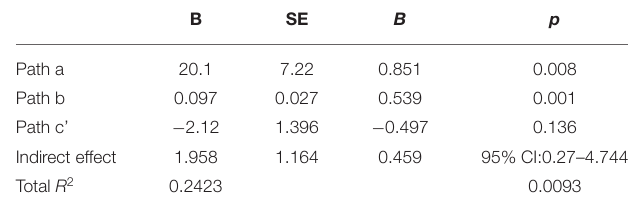
TABLE 4 | Mediation model